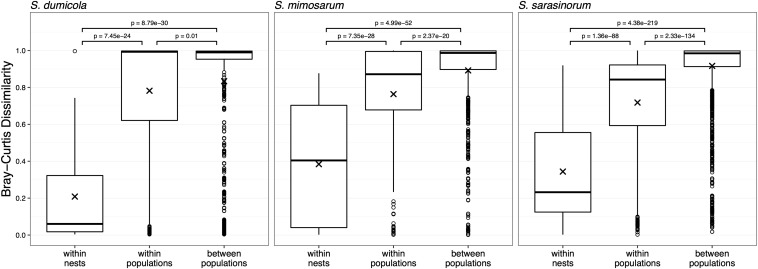
Beta diversity at three different host organization levels (within nest, within population, and between populations) in the three species of social Stegodyphus. Each data point compares the microbiomes of two individual spiders. Bray–Curtis dissimilarities were based on subsampled data. Group means are indicated with “x” and compared using one-way ANOVA and pairwise t-test with Benjamini–Hochberg adjusted p-values.